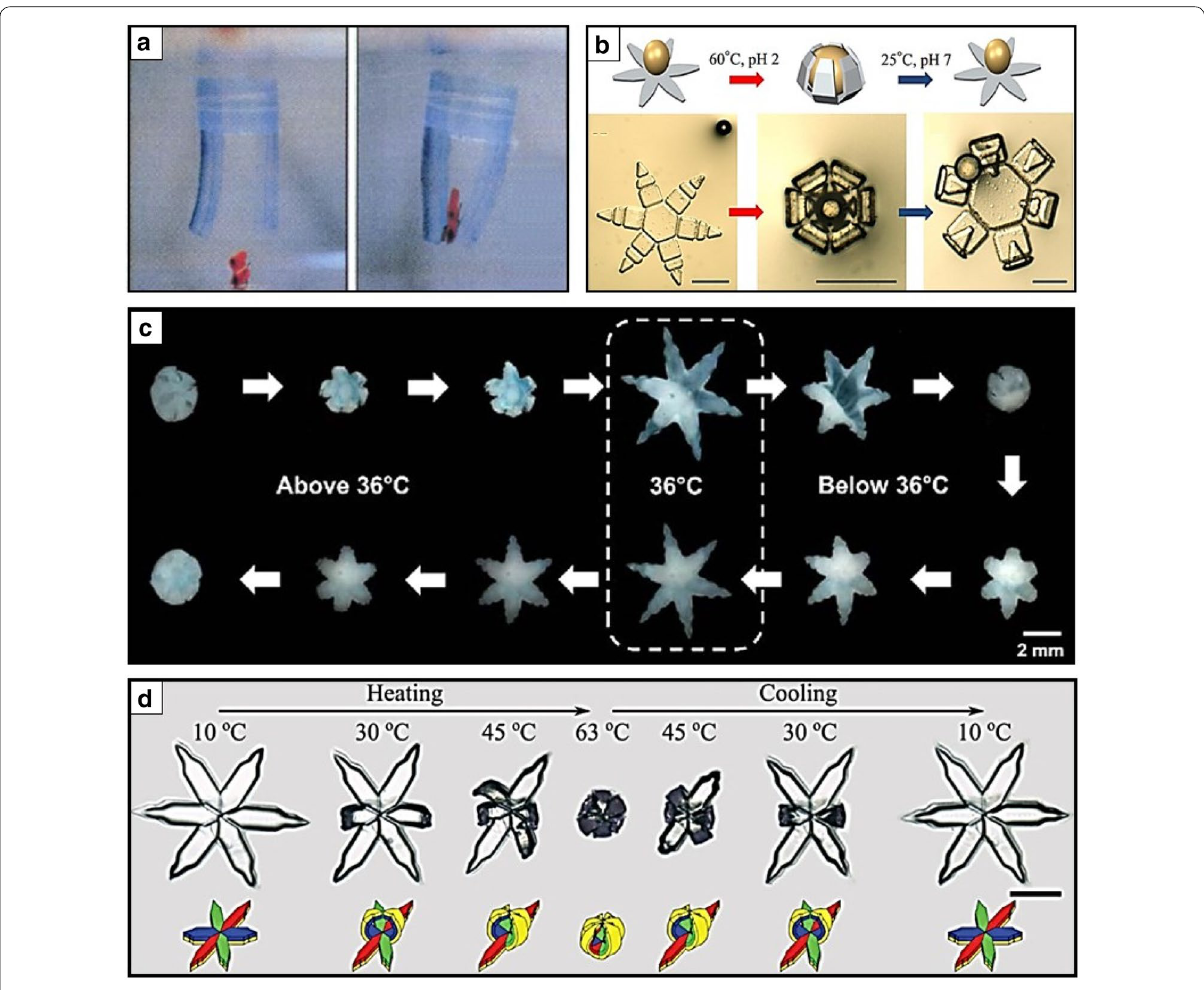
Fig. 1 Biomimetic soft gripping robots composed of stimuli responsive hydrogels, polymer, or hybrid combination of them. a N -isopropylacrylamide (NIPAM)-modulated thermal responsive bigel stripped grippers (reproduced with permission [17]. Copyright 1995, AAAS). b Poly (N -isopropylacrylamide-acrylic acid)(pNIPAM-AAc) soft gripper that reversibly actuates when triggered by temperature or pH (reproduced with permission [13]. Copyright 2014, IOP Publishing). c Thermally responsive self-folding bilayer soft gripper that closes and opens reversibly when passing by LCST at 36 °C (reproduced with permission [9]. Copyright 2015 American Chemical Society). d Reversible four-state shape changes of soft grippers during heating and cooling process (reproduced with permission [26]. Copyright 2018